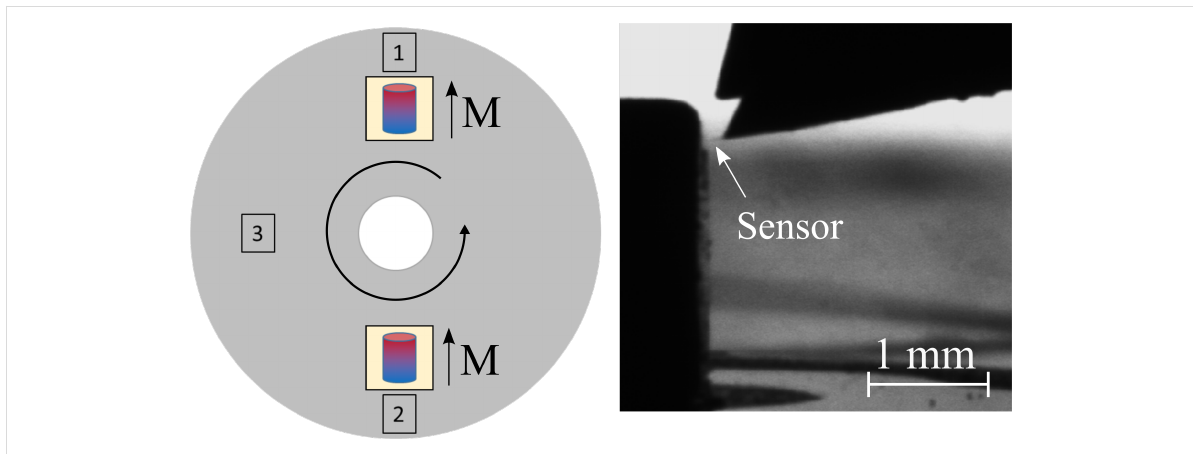
Figure 4: Sketch of measurement positions which are reached by keeping the sensor position fixed and rotating the sample plate. (1) and (2) corre- spond to the two orientations of the magnetic field and (3) is a field-free position. The CCD camera picture on the right hand side shows the sensor close to one of the magnets.